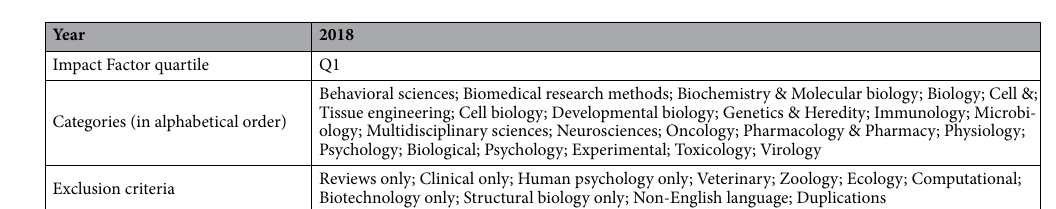
Table 1. Selection criteria applied to the ISI JCR database to get the first list of 504 life science journals and exclusion criteria applied subsequently to obtain the final